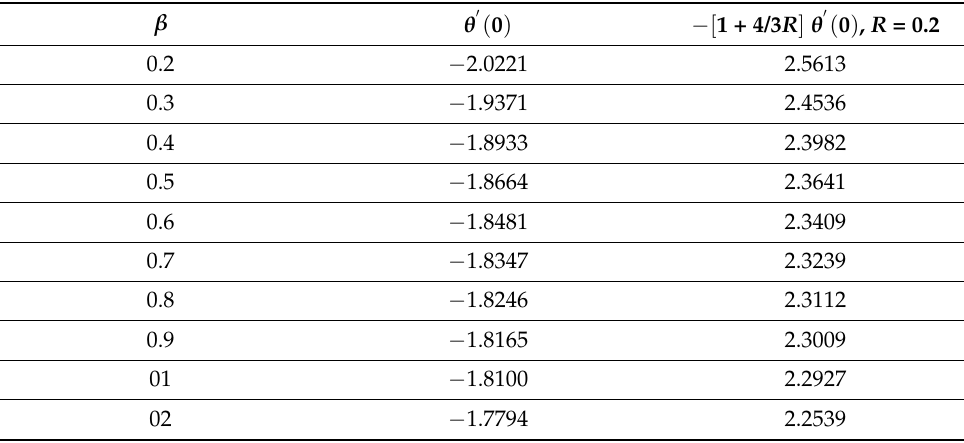
Table 3. Effect of Casson fluid parameter on Nusselt